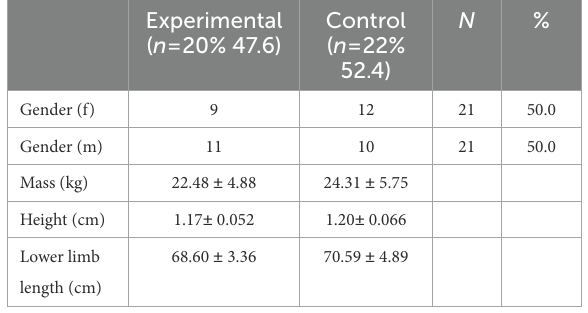
TABLE 1 Demographic characteristics and frequency percentage distributions and average values of the 5-year-old preschool children participating in the